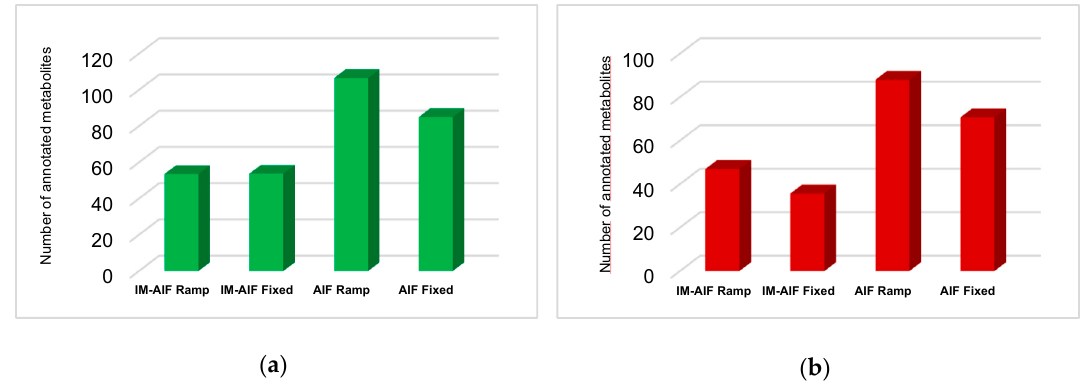
Figure 4. Average metabolite annotations by IM-AIF ramped and fixed CID and AIF ramped and fixed CID for ( a ) aHILIC ESI+ (green); and ( b ) zHILIC ESI- (red).